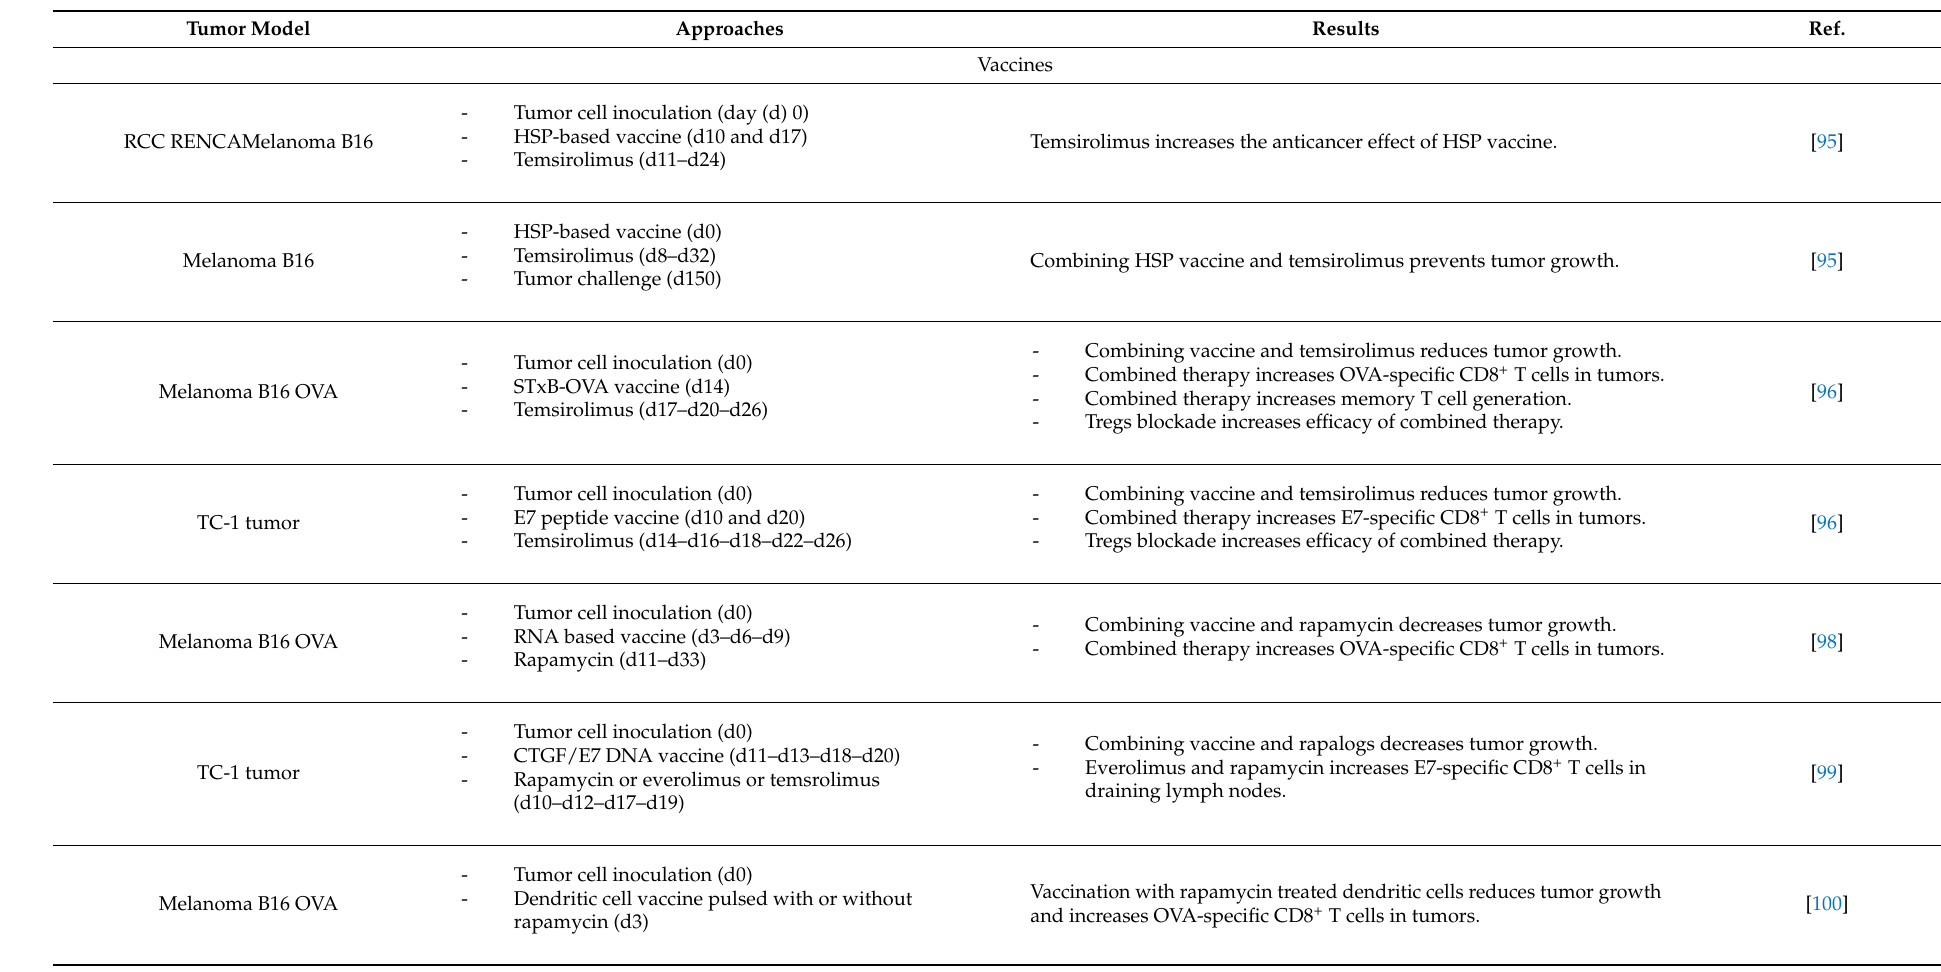
Table 2. mTOR inhibitors and immunotherapies in preclinical cancer